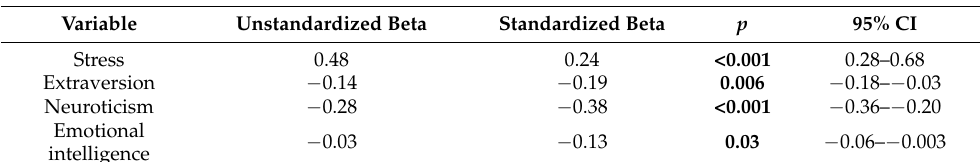
Table 4. Multivariable analyses. Model 1: Linear Regression Taking the Depression Score as the Dependent Variable.